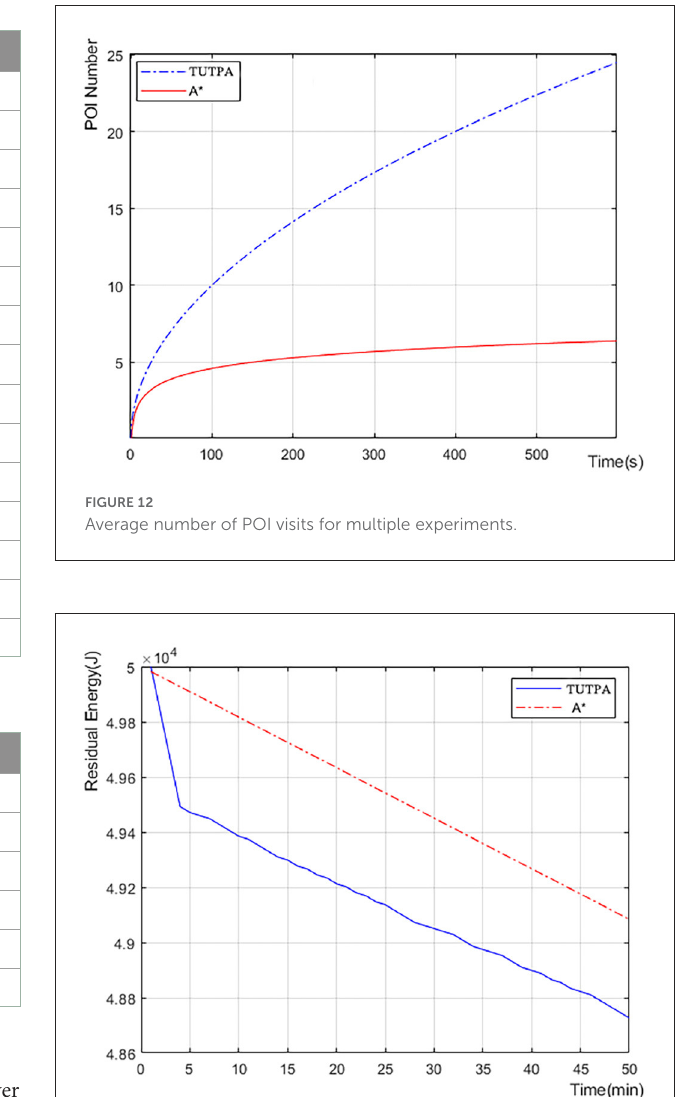
TABLE 4 Statistics of UAV simulation parameters.